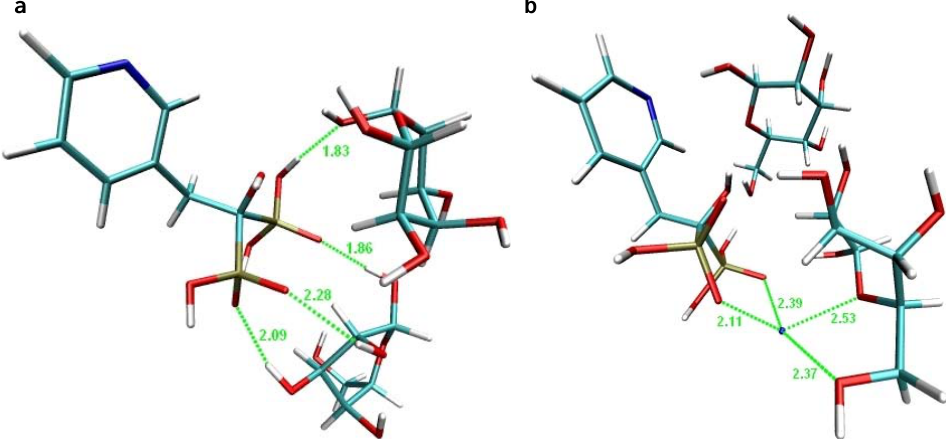
Figure 18. Illustration of supposed interactions of risedronate mono-sodium salt with β - D -allopyranose: (a) suggested interaction between molecule of risedronate and allose; (b) suggested interaction between sodium cation and allose.